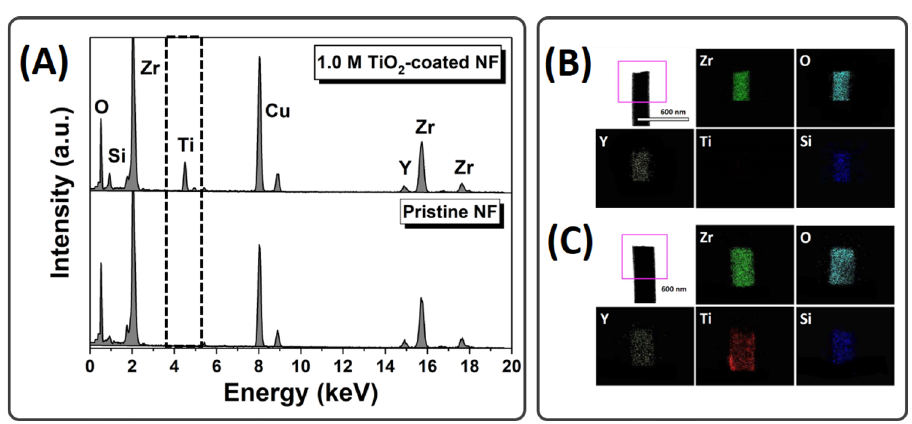
Figure 2. HR-TEM micrographs of YSZ/silica and TiO 2 -coated YSZ/silica NF: ( A ) EDS spectra of pristine NF and 1.0 M TiO 2 -coated NF and elemental maps of ( B ) pristine NF and ( C ) 1.0 M TiO 2 -coated